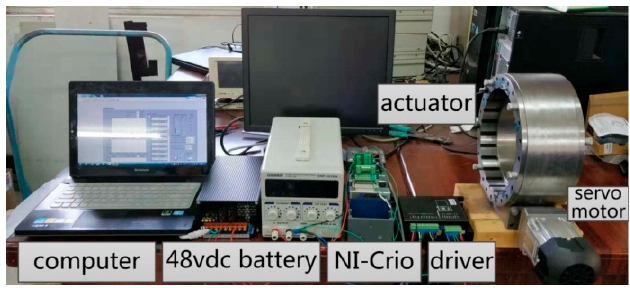
Figure 10. The response test of the BLDC motor.